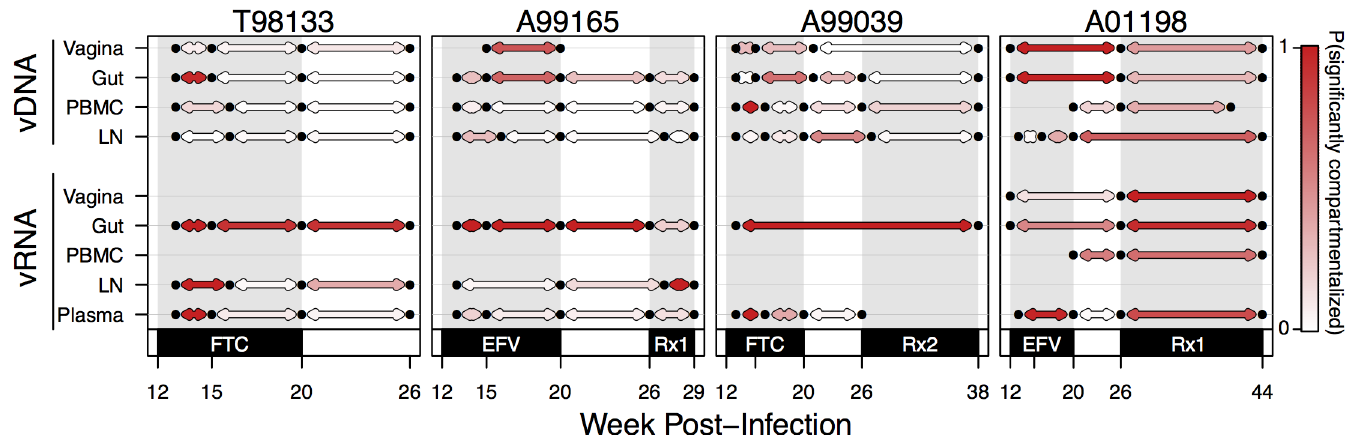
Fig 8. Change in compartmental viral composition over time varies by compartment and drug pressure. For each macaque,K ST tests are plotted betweenall time points with adjacent samples (i.e., week 12 or 13 comparedto week 15 or 16) for each compartment (vRNA top, vDNA bottom). Black dots indicatetime points with samples of at least 3 sequences.Red lines indicatethat a K ST test comparingthose two samples is significantly different (with a 5% FDR). Grey lines indicatea failure to reject the null hypothesisof being well-mixedat the 5% FDR level. Grey shadingindicatesmonotherapyor combination therapy, as indicatedbelowthe x-axis. Rx1 is treatment FTC+TFV+EFV and Rx2 is the treatment TFV+L870812+DRV/r.